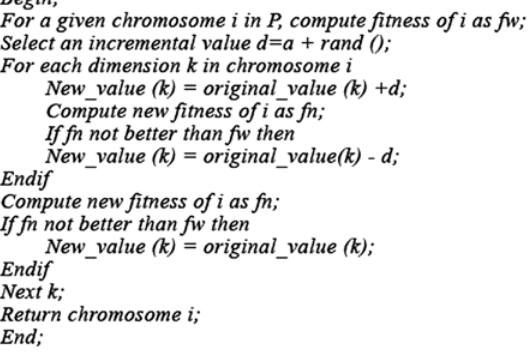
Figure 2: Pseudo-code for Local Search Technique in